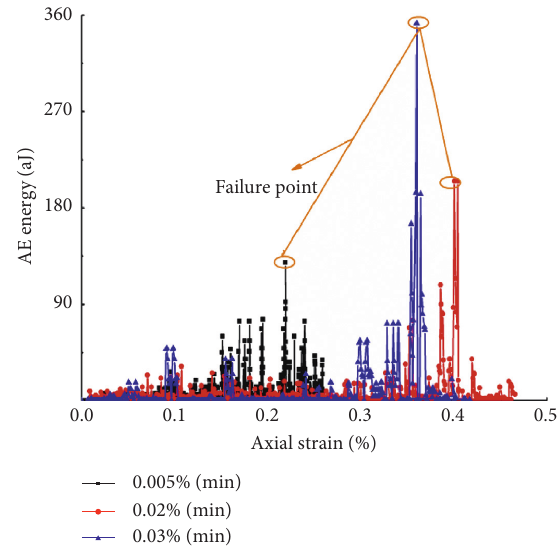
Figure 7: Corresponding curves of AE energy strain under different strain